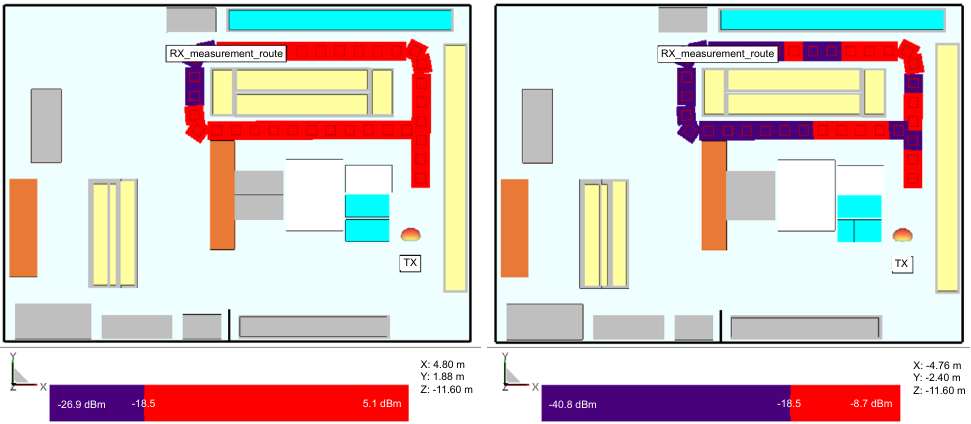
Figure 12. Simulation results of P tag distribution along a trajectory of a Higgs 4 tag attached to a cardboard ( left ) and water product ( right